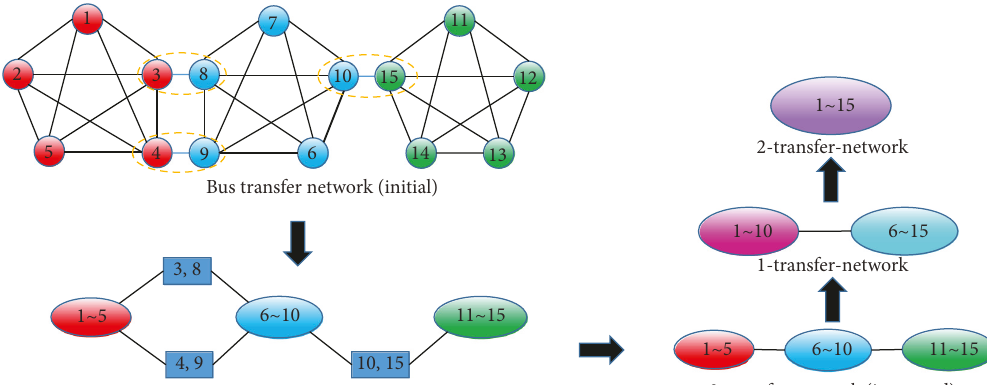
Figure 7: Community detection of bus transfer